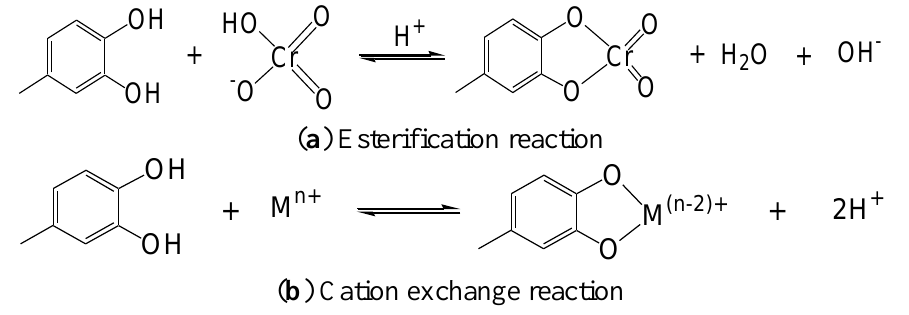
Figure 8. Effect of equilibrium pH on the adsorption of different metal ions on CPW gel [23] (with permission for reuse from Elsevier B.V.).